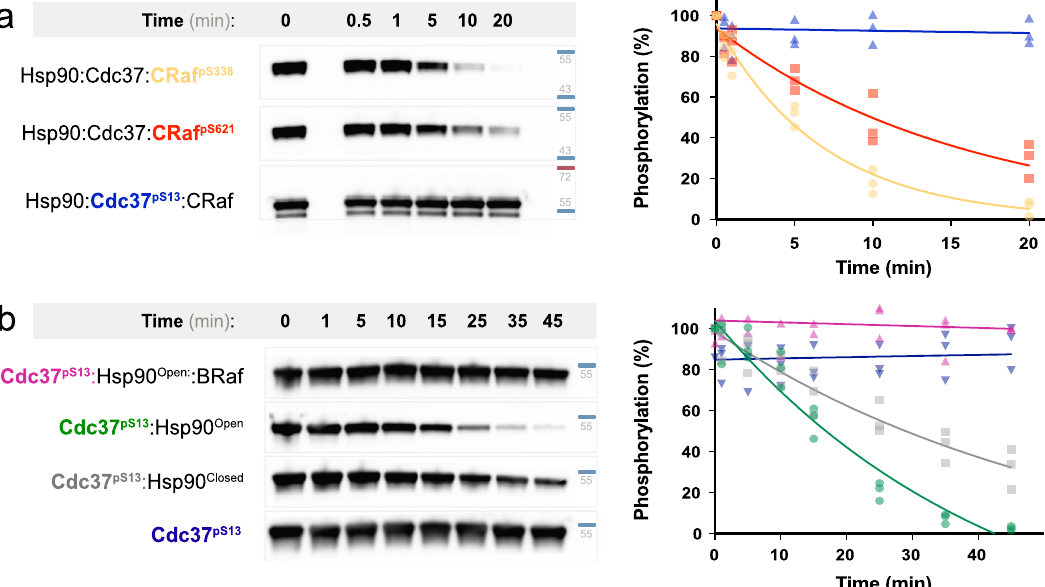
Fig.1|KinasestericallyblocksCdc37dephosphorylation.a Mammalianpuri fi ed Hsp90:Cdc37:CRafcomplex (1.5mM) was incubated withPP5 (75nM) at25°C. The dephosphorylation of CRaf pS338 , CRaf pS621 and Cdc37 pS13 was assayed by phospho- speci fi c blotting ( n =3, rate ± SEM). CRaf pS338 was preferentially